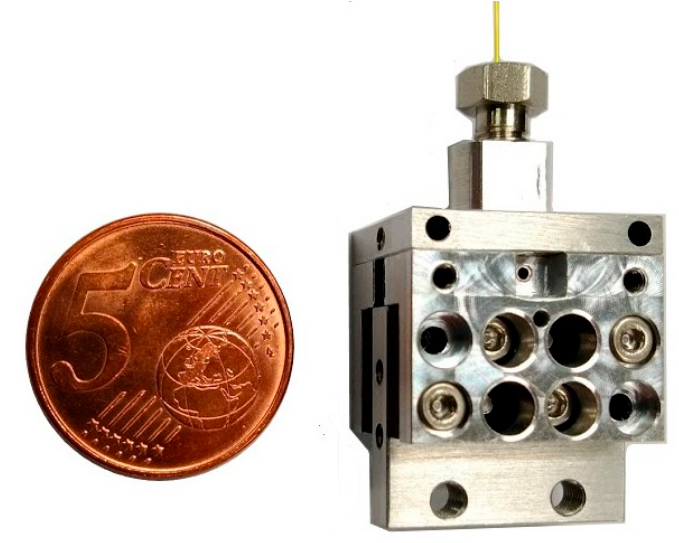
Figure 4. Miniaturized QEPAS cell.